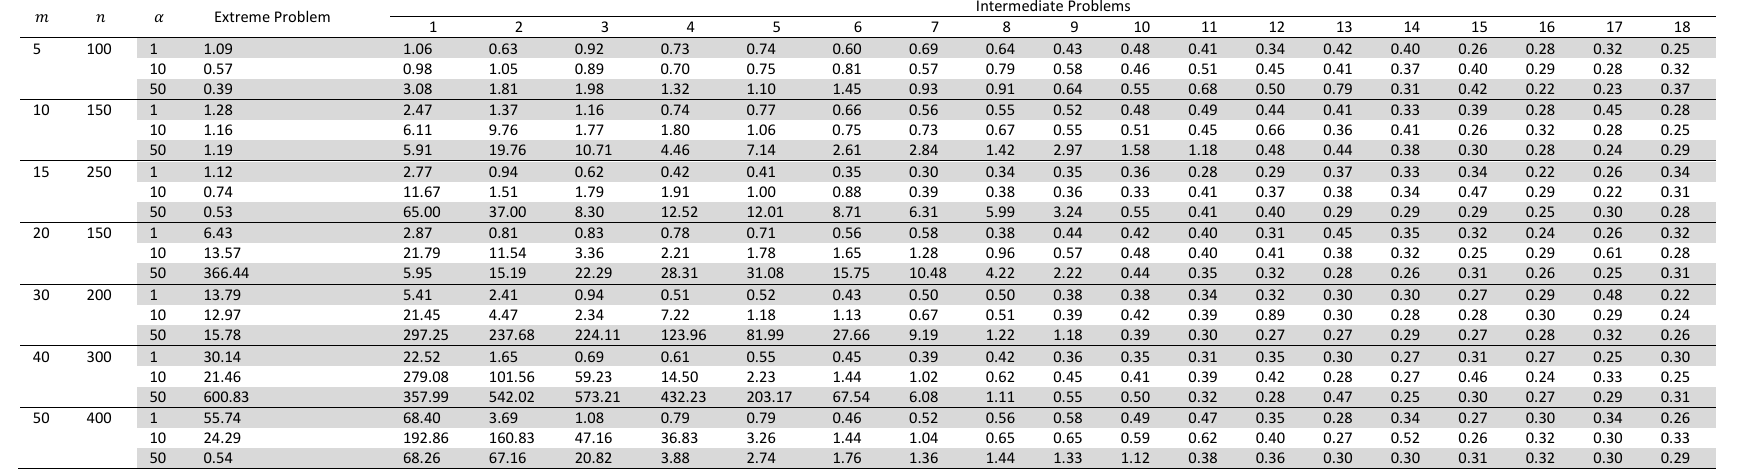
Detailed average solution times of the single-objective problems in some problem classes